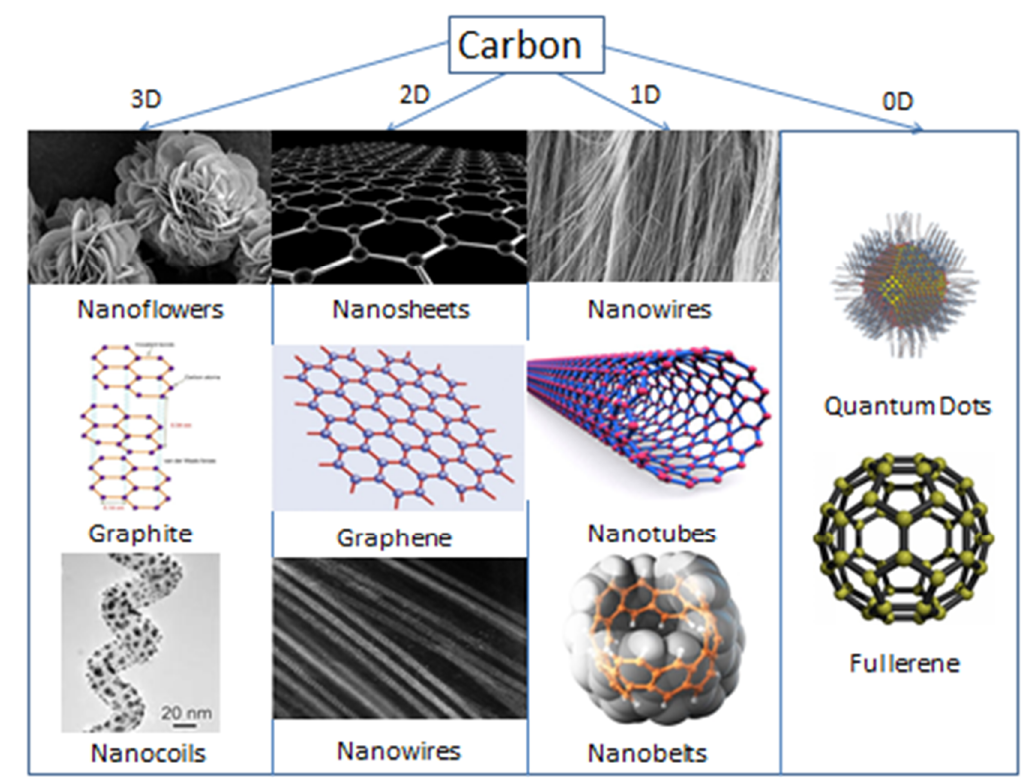
Figure 4. Carbon nanostructures in all three dimensions. Reproduced with permission from [48].